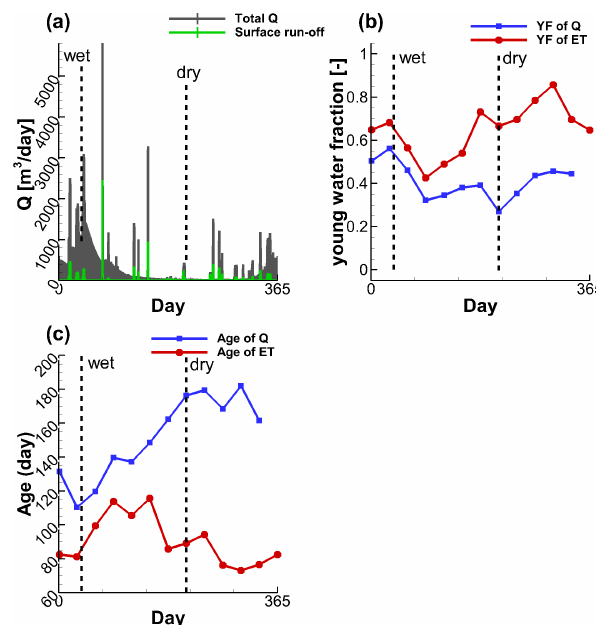
Figure 3. Simulated (a) Q , (b) young water fractions in streamflow (YF Q ) and evapotranspiration (YF ET ) , and (c) water ages for the catchment of the base scenario. The YF and water ages are monthly